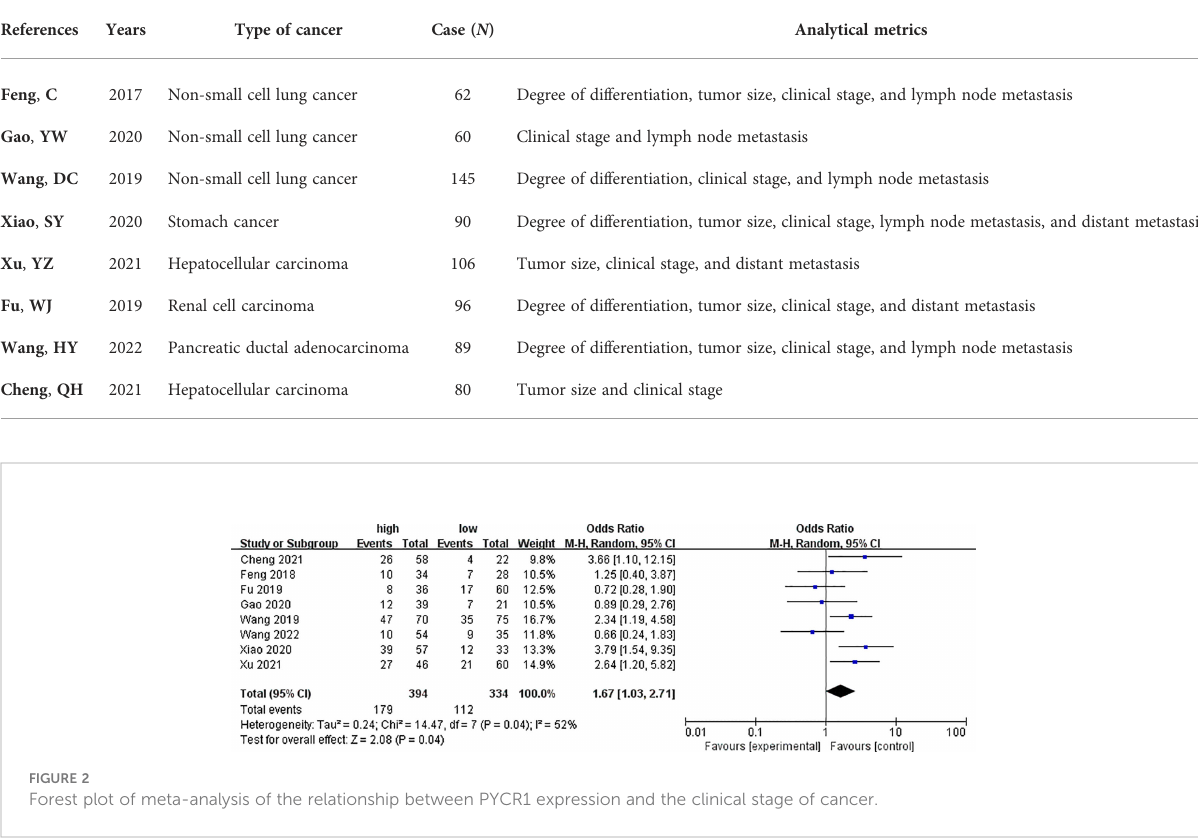
TABLE 1 Basic characteristics of the included studies.